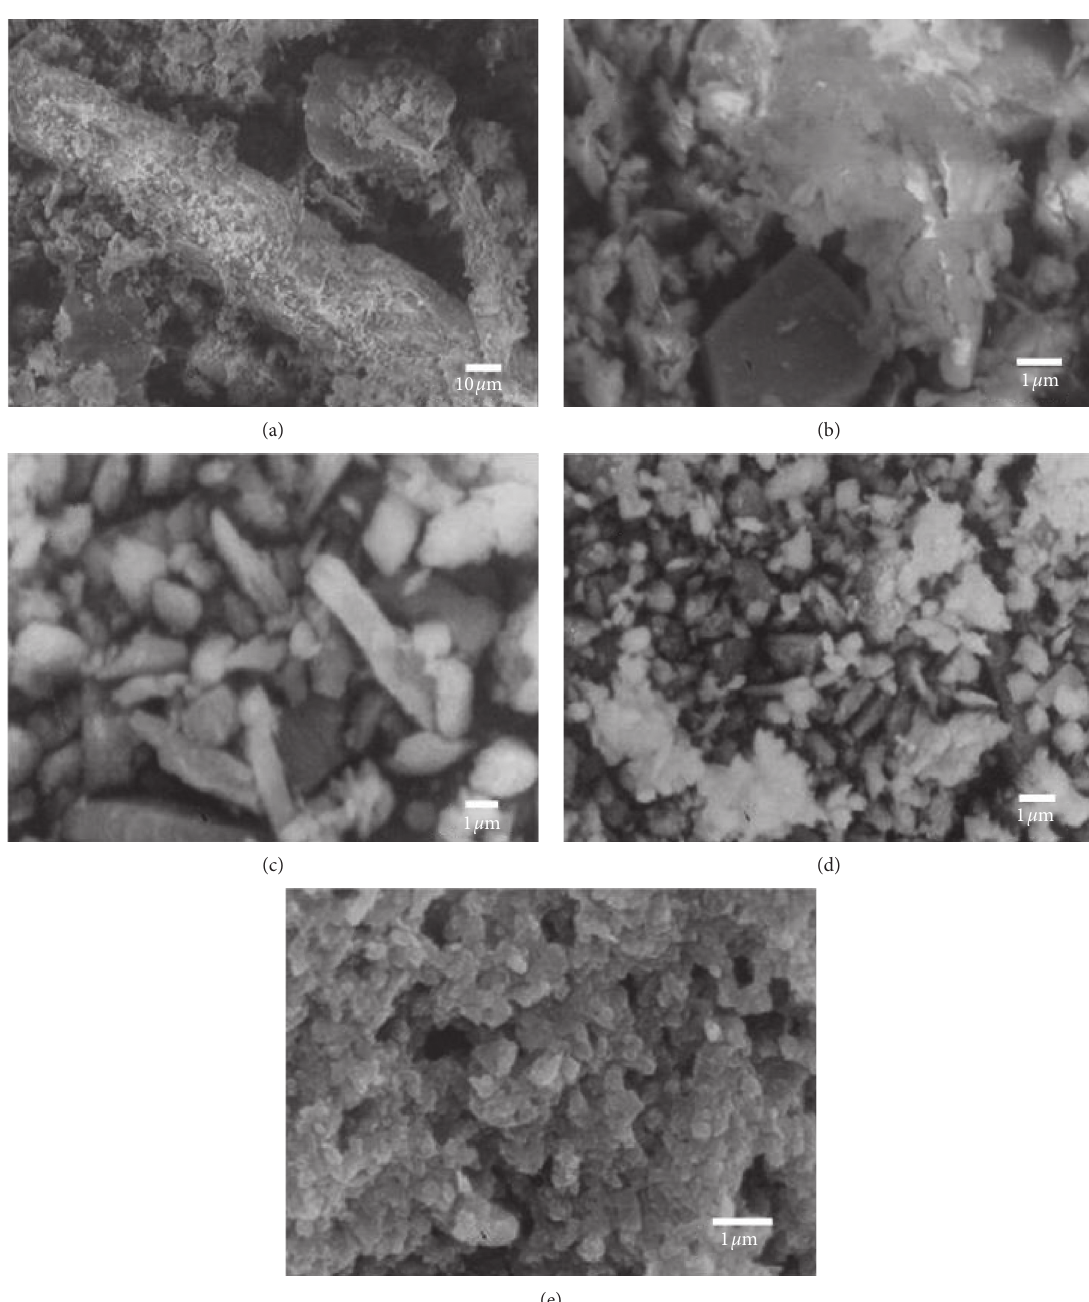
Figure 3: Micrographs of kyanite-aluminum mixtures milled at different times: (a) KA0h, (b) KA0.5h, (c) KA3h, (d) KA6h, and (e)